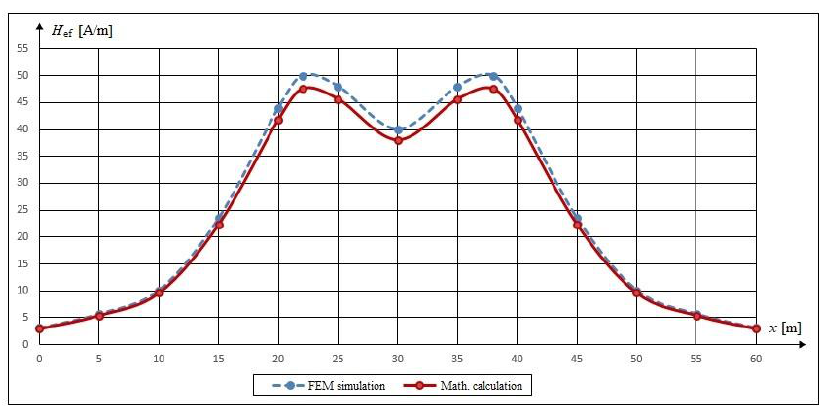
Figure 4. Distribution of the six groups of effective values of magnetic field strength at 1.5 m above the ground, obtained through calculation and FEM